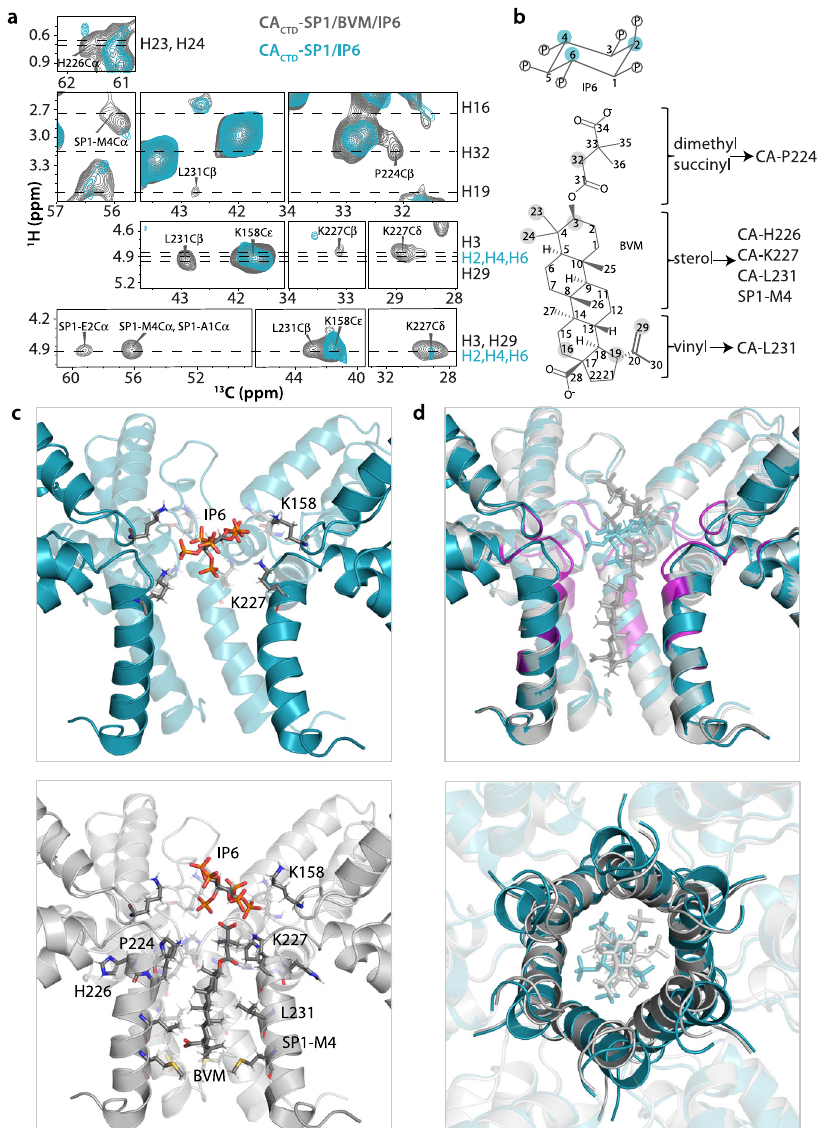
Fig. 2 | MAS NMR structure of BVM- and IP6-bound CA CTD -SP1. a Superposition of selected regions of 2D HC CP HETCOR spectra (top three panels) and 2D dRE- DOR-HETCOR spectra (bottom panel) of U- 13 C, 15 N, 2 H-CA CTD -SP1/BVM/IP6 (gray) and U- 13 C, 15 N, 2 H-CA CTD -SP1/IP6 (cyan) assemblies. The BVM and IP6 1 H atoms and CA CTD -SP1 residueswith 13 C atoms are indicated outside and insideeachspectrum, respectively. b Chemical identity of IP6 and BVM molecules. The IP6 and BVM protons interacting with CA CTD -SP1 residues are shown in cyan and gray, respec- tively. c Top panel: IP6 binding mode in the hexamer of CA CTD -SP1/IP6 assemblies